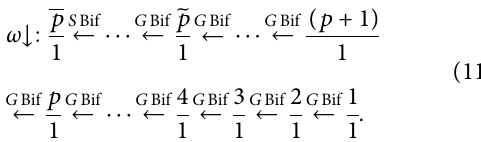
Figure 10: Time series of sticking motion when ω � 0 . 35. (a) Time series of x _ x − _ x ; (d) local enlargement of Figure 1 2